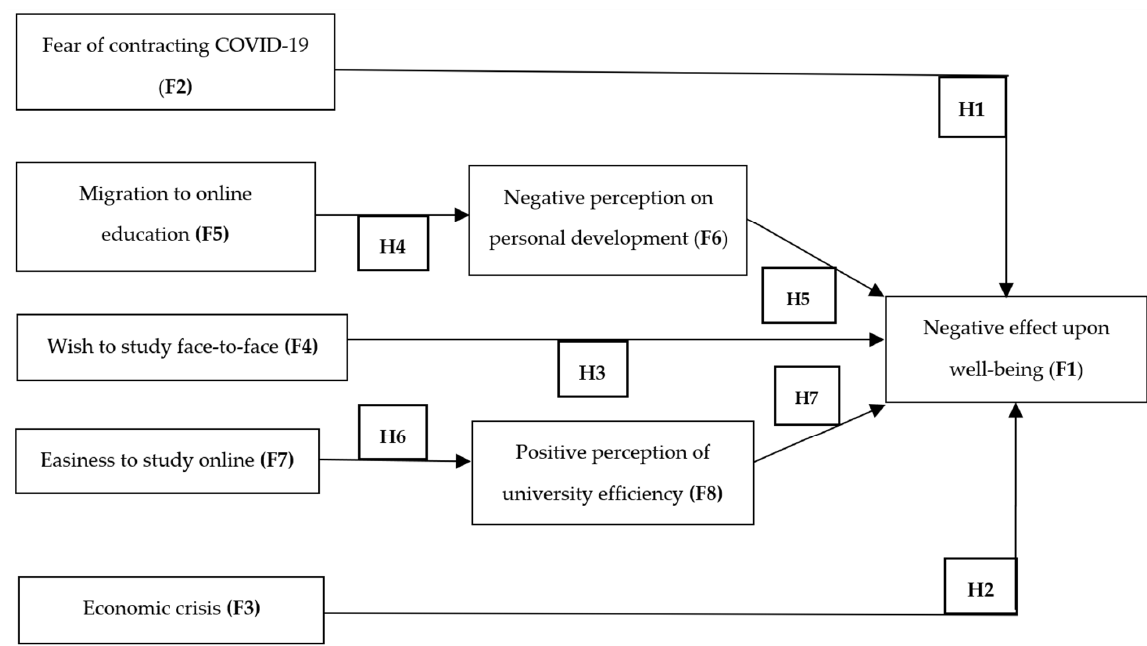
Figure 1. The structural model (F: factor).